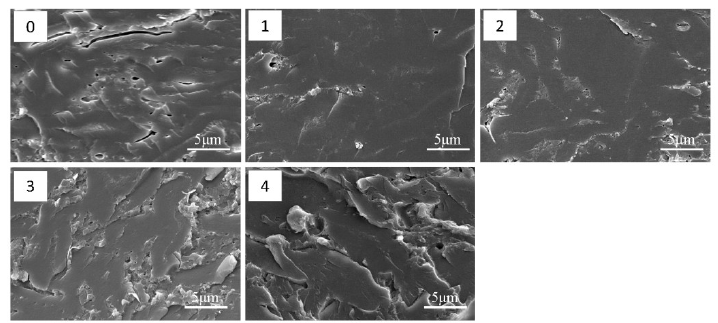
Figure 6. The fracture surface micrograph of di ff erent adhesive samples: 0: WF adhesive, 1: WF / HMP-10 adhesive, 2: WF / HMP-20 adhesive, 3: WF / HMP-30 adhesive, 4: WF / HMP-40 adhesive.